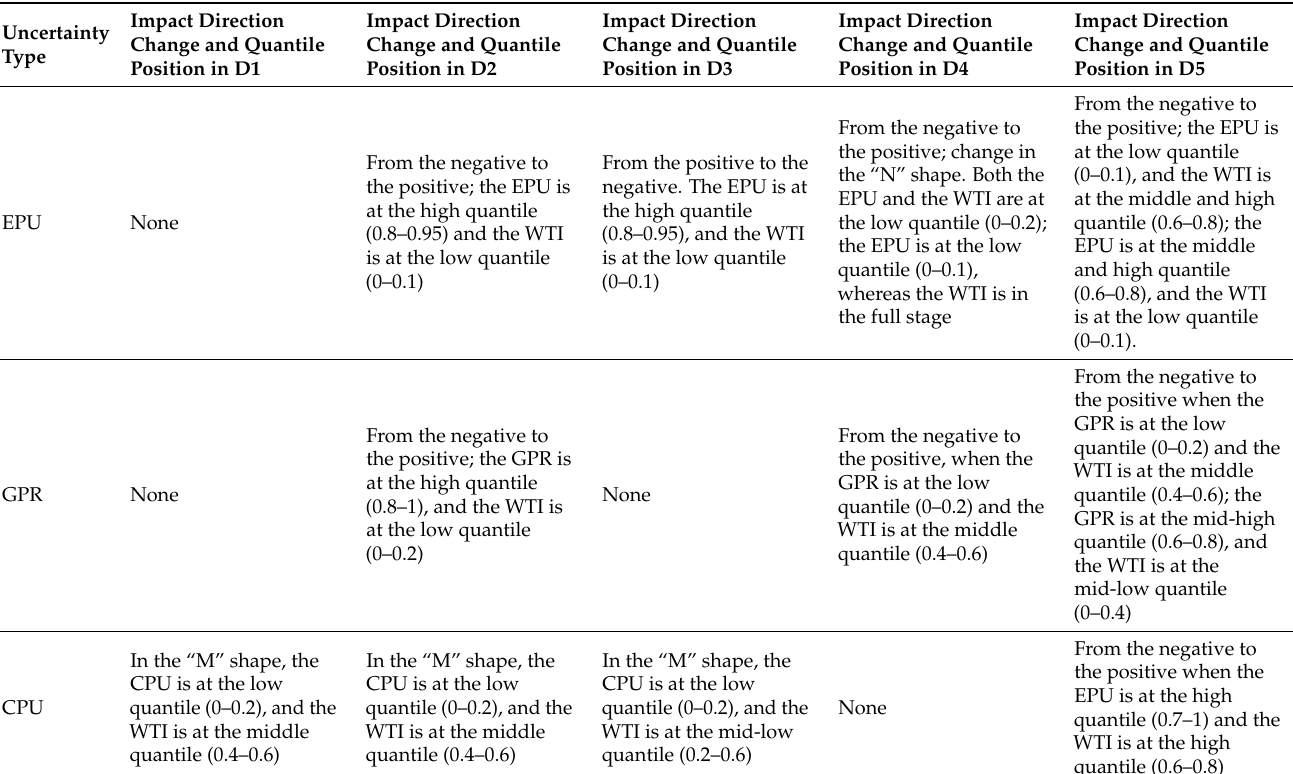
Table 8. Comparison of the impact direction of three uncertainty indexes on crude oil price under different time